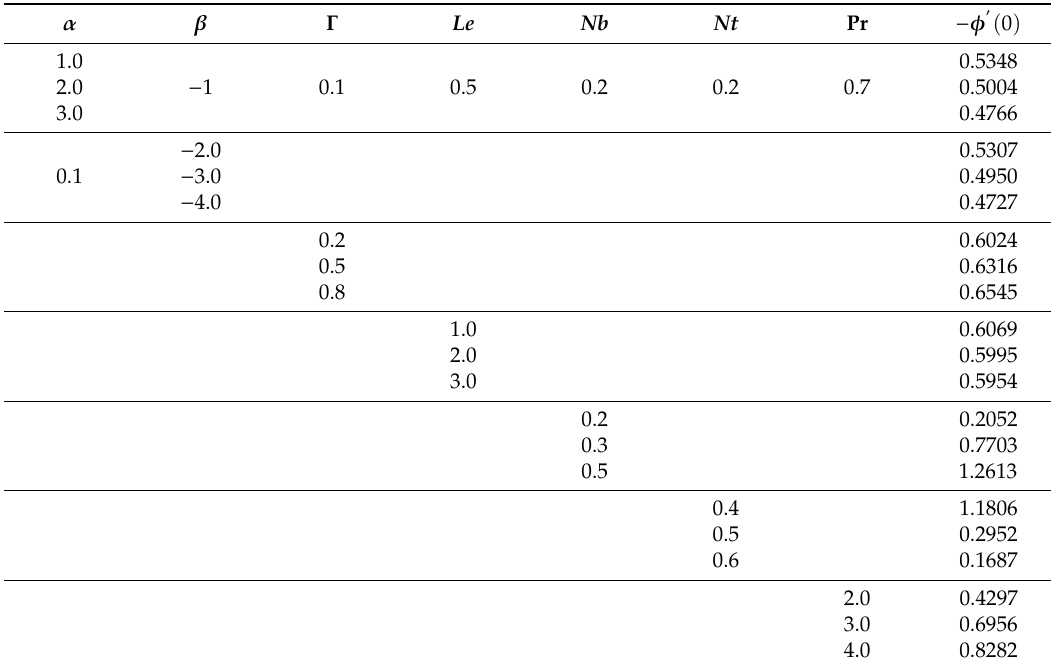
Table 4. Variation in local Sherwood number − φ (cid:48) ( 0 ) for α , β , Γ , Le , Nb , Nt and Pr.